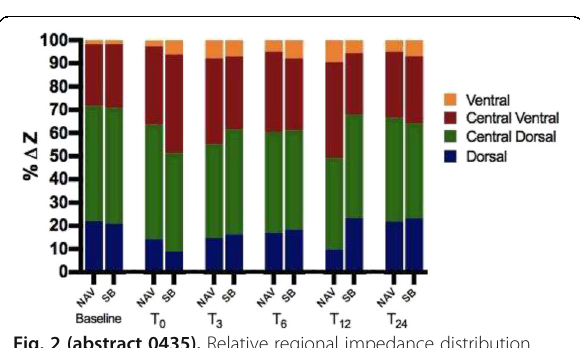
Fig. 2 (abstract 0435). Relative regional impedance distribution. NAV: near-apneic ventilation; SB: spontaneous